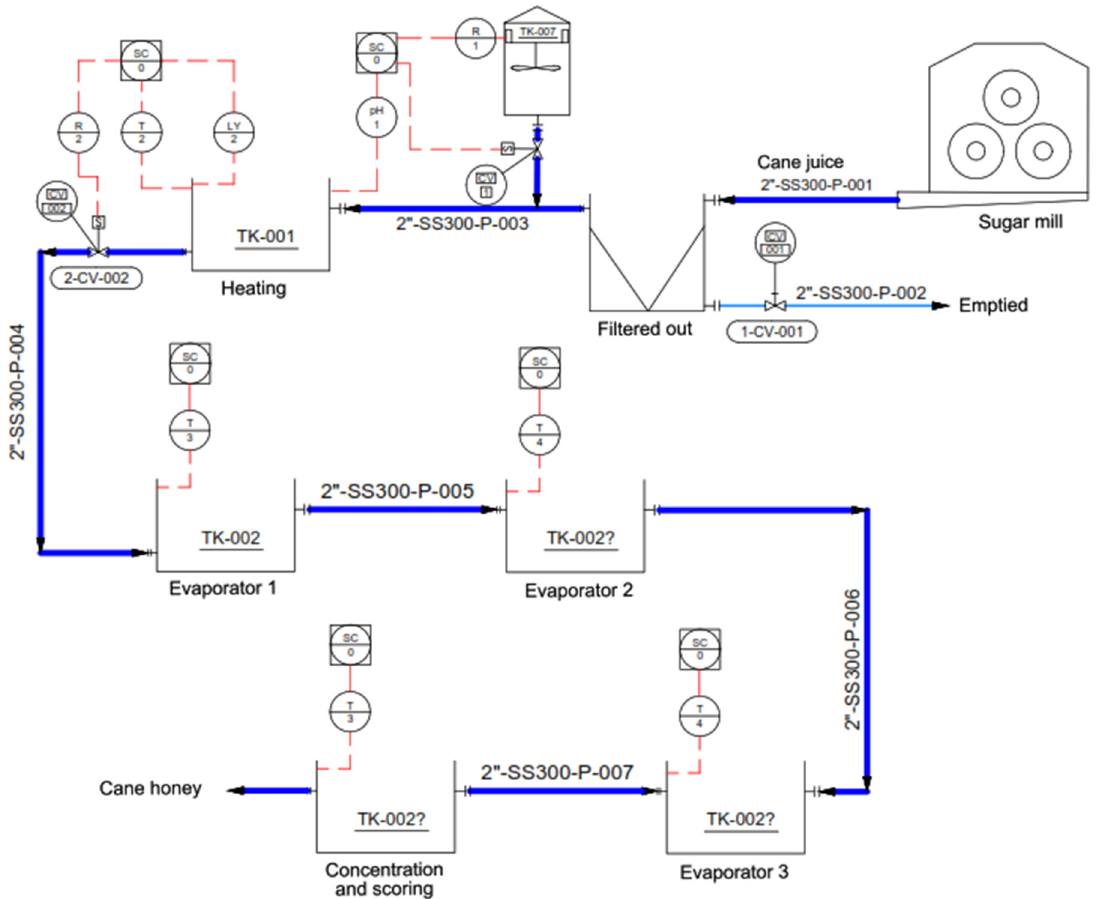
Figure 2. P&ID diagram of the artisanal sugarcane honey production process.